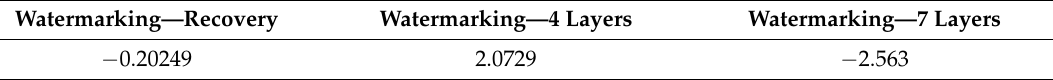
Table 6. The SNR values of the recovered speech signal with different numbers of hidden layers.